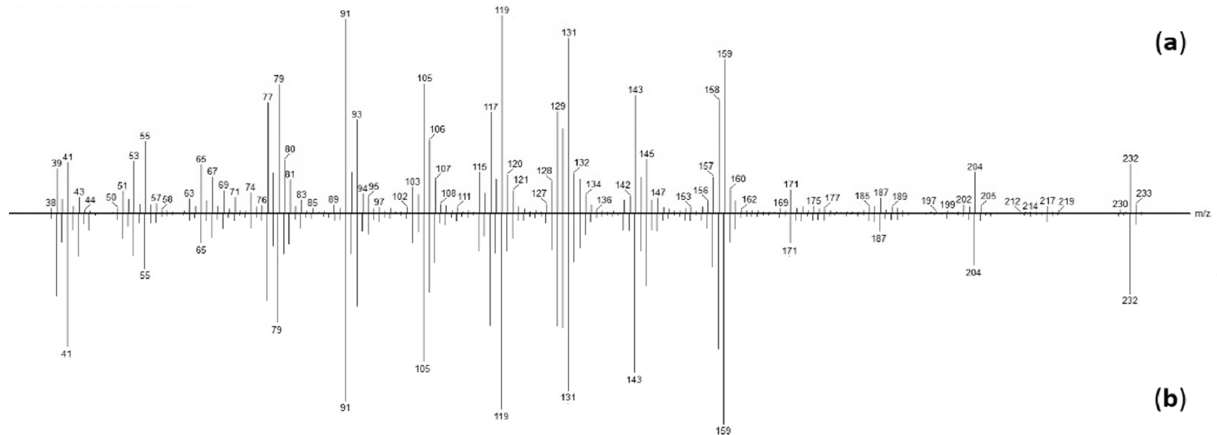
Figure 4. EI-MS spectrum of ( a) compound 67 ; ( b ) xantholide B 65